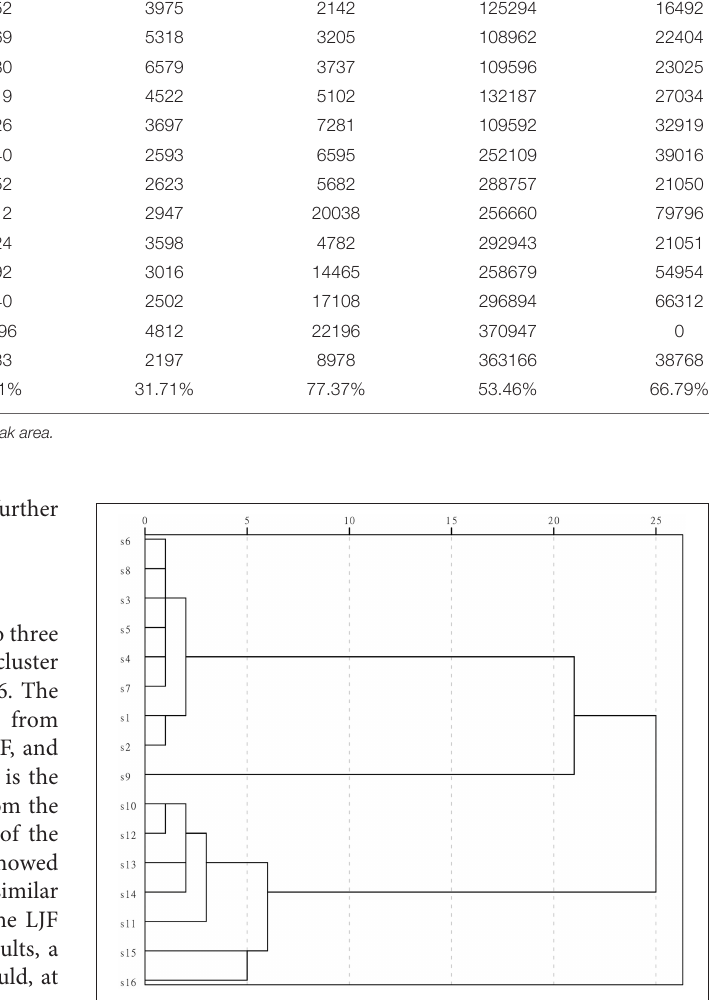
FIGURE 3 | Dendrogram of the HCA results for the UPLC fingerprints of 16 batches of extracts. SPSS statistics software (SPSS for Windows 13.0, SPSS Inc., USA) was used to conduct the HCA and used the average linkage method and squared Euclidean